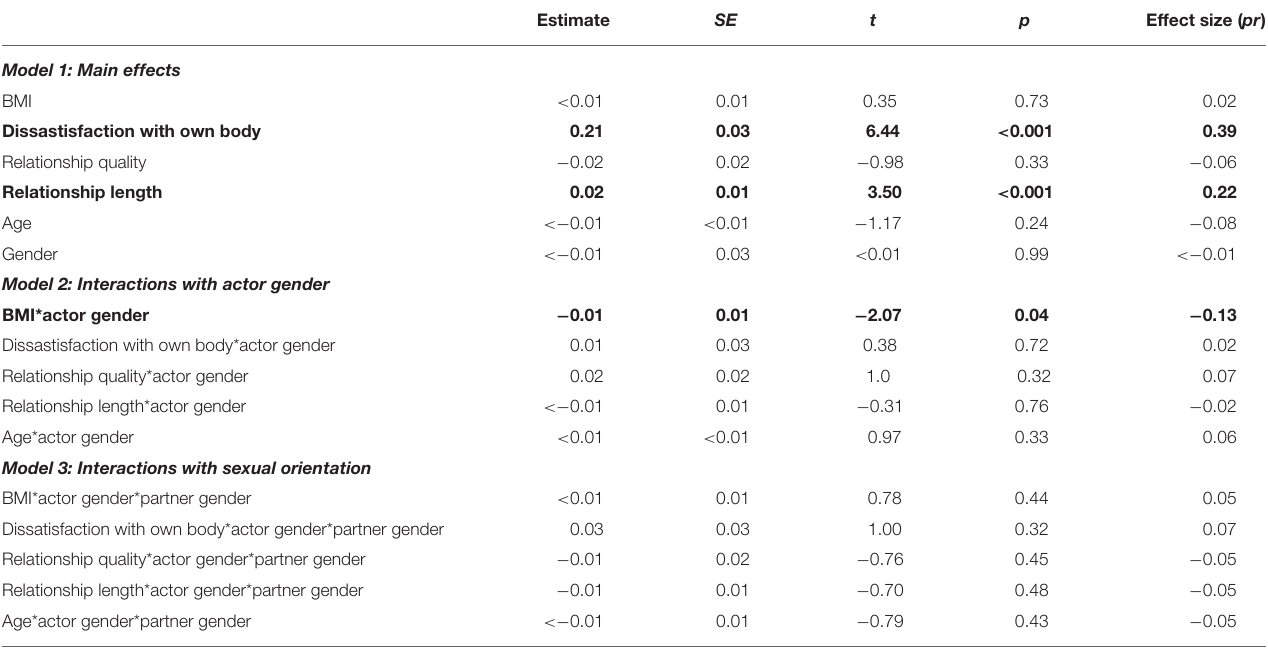
TABLE 2 | Multilevel models predicting participants’ perceptions of their own weight change ( N = 500).